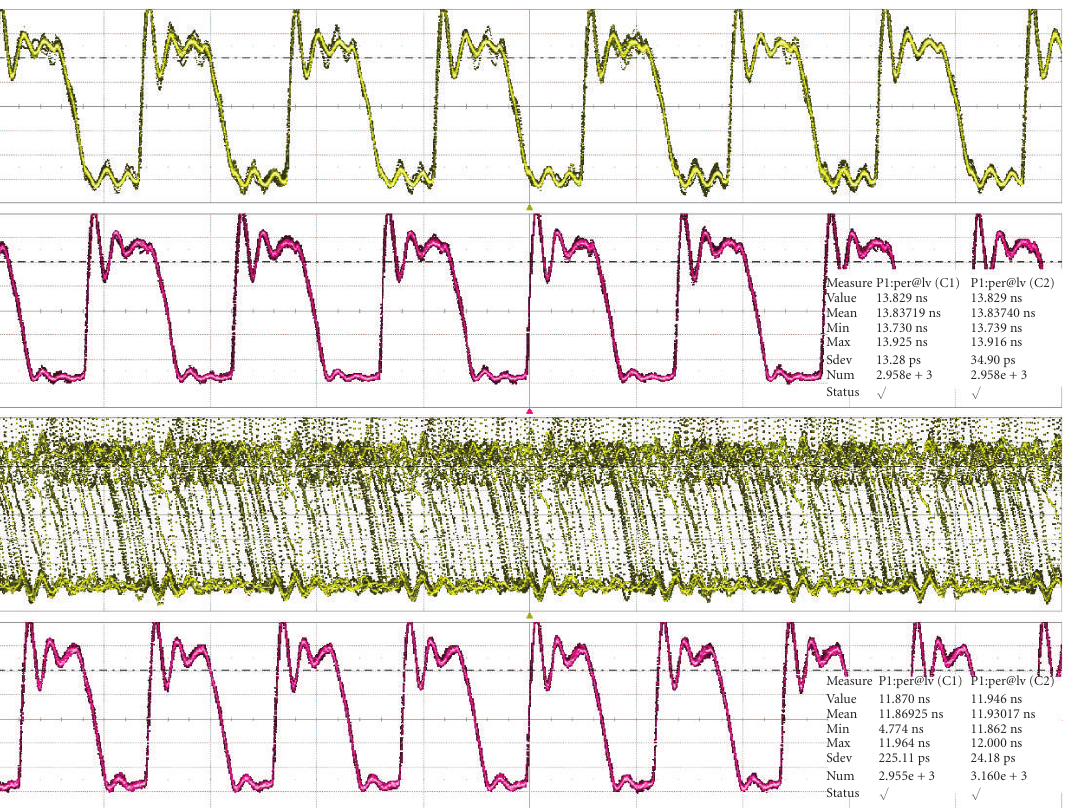
Figure 13: Waveforms of two locked (up) and unlocked (down) rings in Actel Fusion